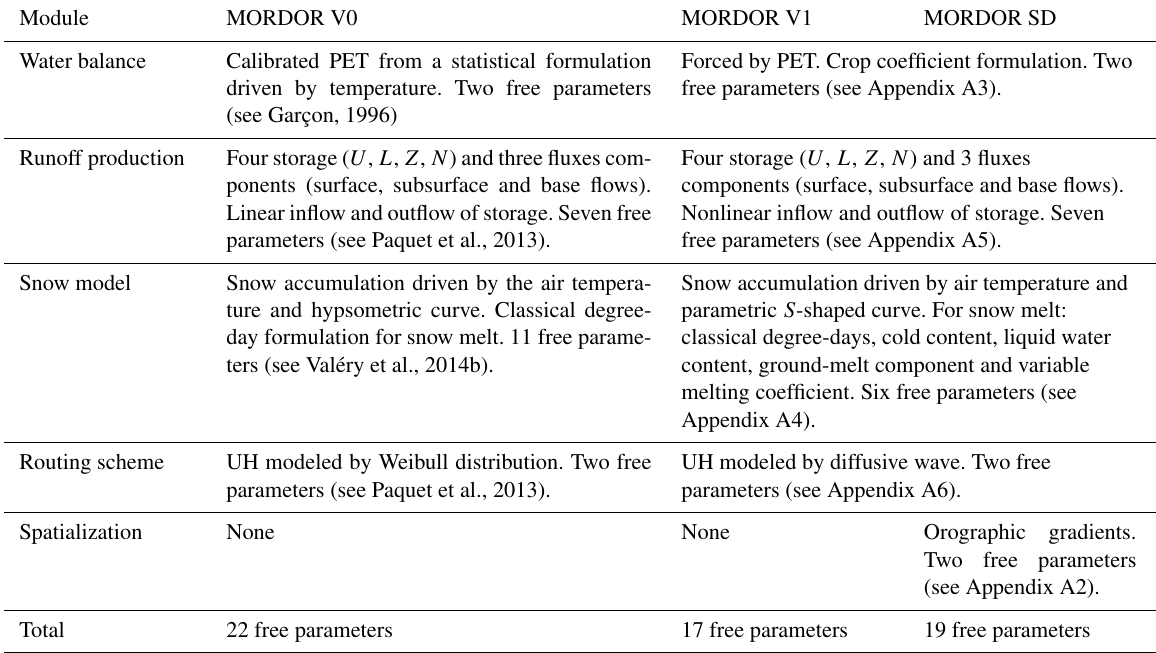
Table 1. Main components of MORDOR V0, V1 and SD models in terms of water balance, runoff production, snow model, routing scheme and spatialization. For each module and model, the number of free parameters is given.